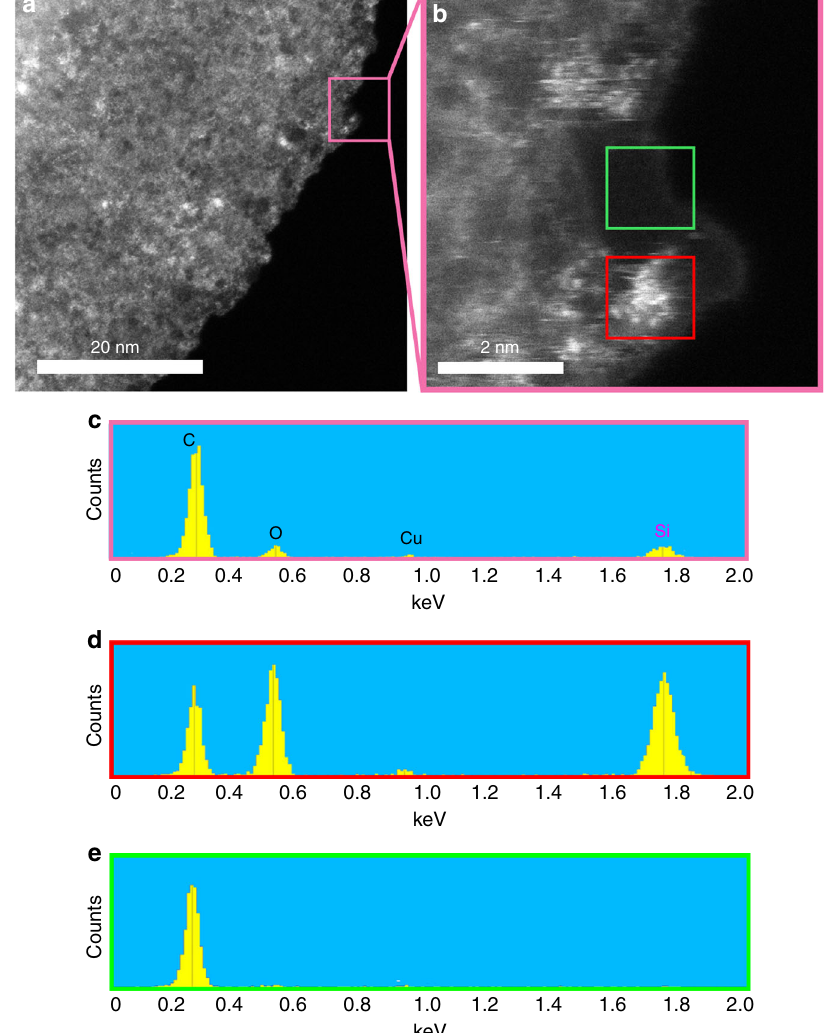
Fig. 3 The extent of silicon contamination on the surface of typical solvent-exfoliated graphene derived from low-purity graphite (98% purity). a HAADF image of a typical graphene sheet. b Detail of HAADF image of the boxed region in a . c EDS spectrum of the boxed region in a . The strong Si peak at 1.739 keV con fi rms the presence of signi fi cant contamination. d , e A comparison of the EDS spectra of the contaminated area ( d ) and non-contaminated and monolayer area ( e ), which are marked as red and green boxes in b ,